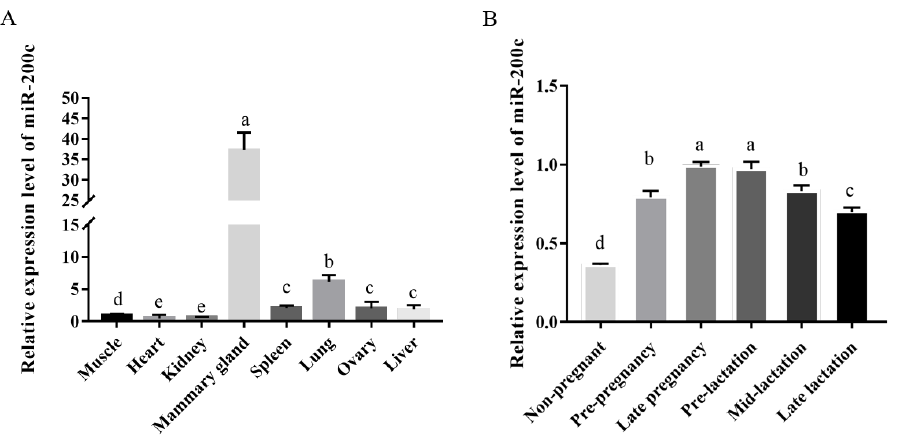
Figure 1. The expression level of miR-200c in the ovine eight different tissues ( A ) and the mammary gland at different developmental stages ( B ). The data are shown as mean ± SD ( n = 3). Values with different lowercase letters are different at p < 0.05.